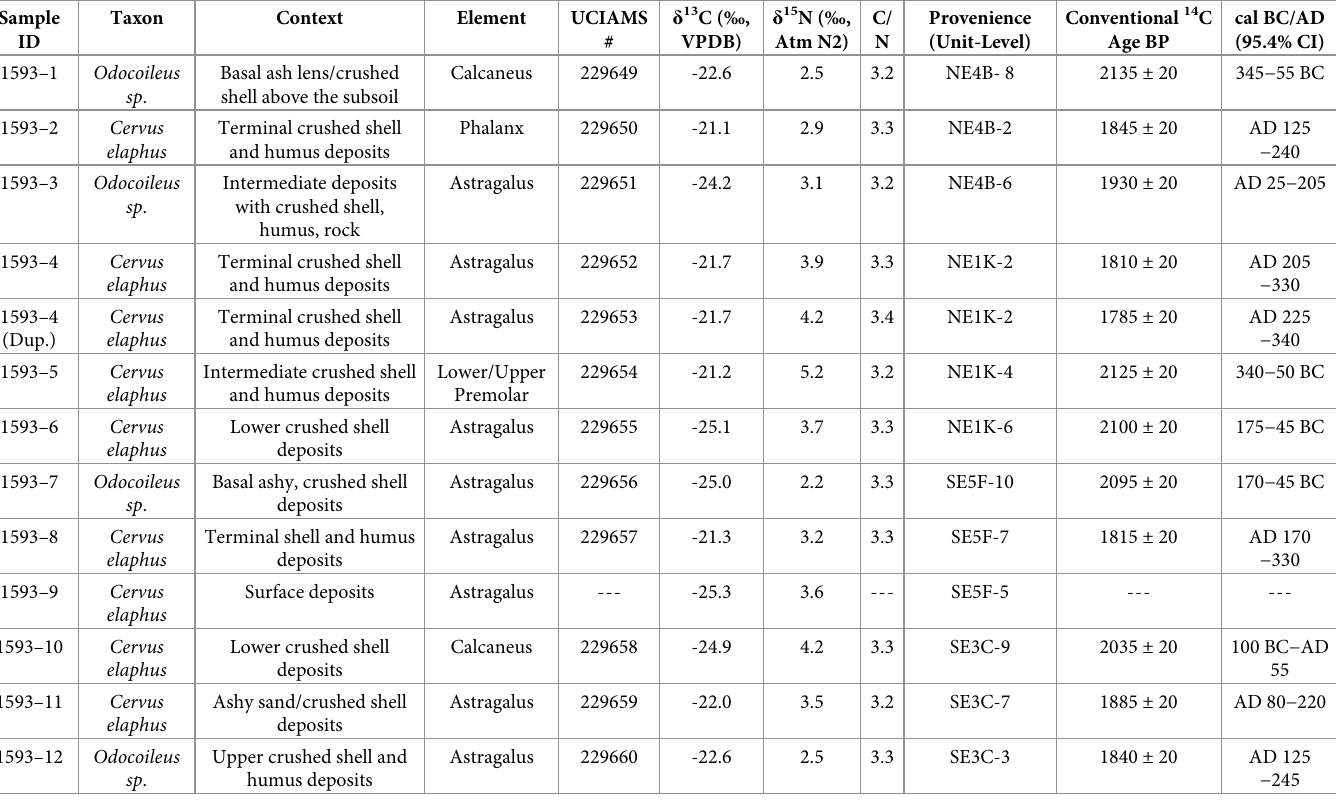
Table 2. Conventional and calibrated AMS 14 C dates on cervid bone from the Palmrose site. Context designations derived from Phebus and Drucker field notes. Sample